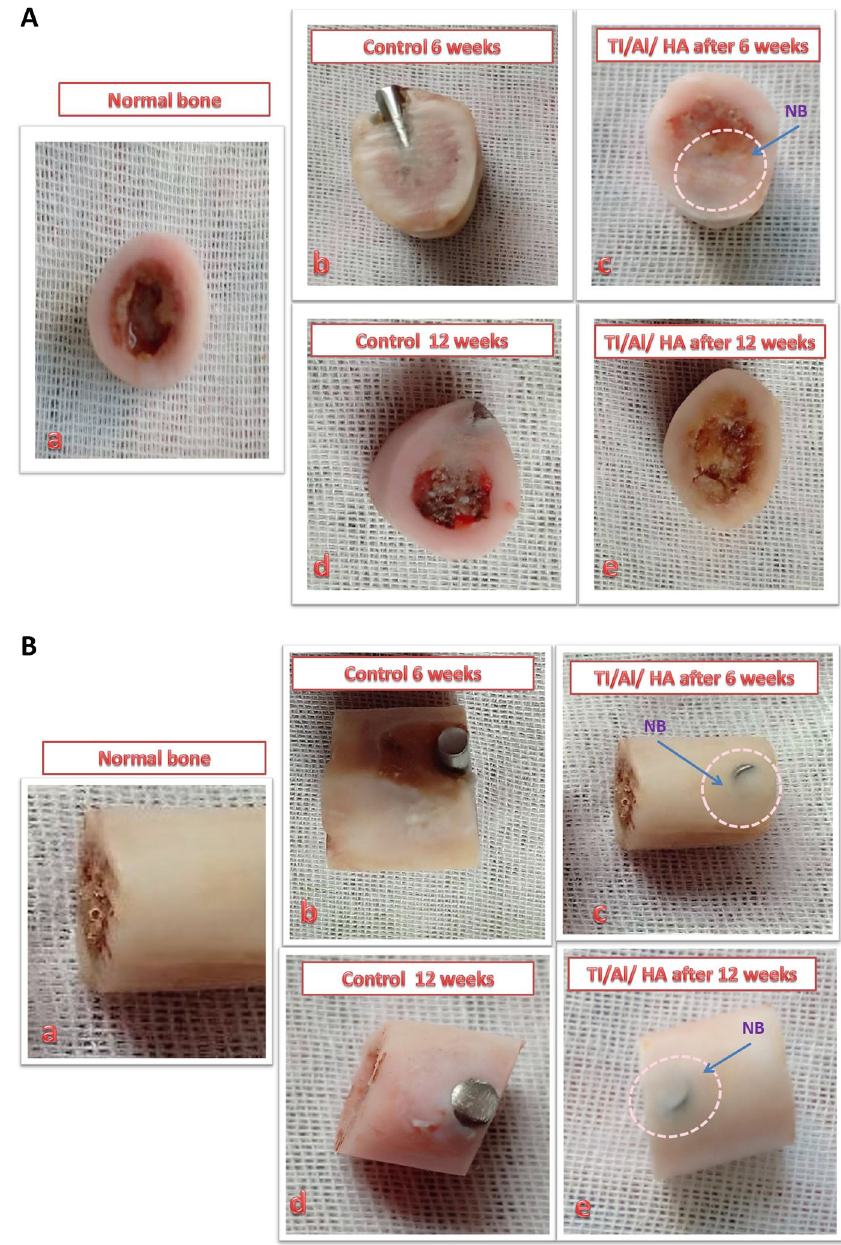
Fig. 2 A Cross-sections of femur bones: (a) normal, (b) control group after 6 weeks (Group I), (c) treated group after 6 weeks (Group III), (d) control group after 12 weeks (Group II), and (e) treated group after 12 weeks (Group IV). B Femur bones: (a) normal, (b) control group after 6 weeks (Group I), (c) treated group after 6 weeks (indicating newly formed bone [NB]) (Group III), (d) control group after 12 weeks (Group II), and (e) treated group after 12 weeks (proving the formation of new bone [NB]) (Group